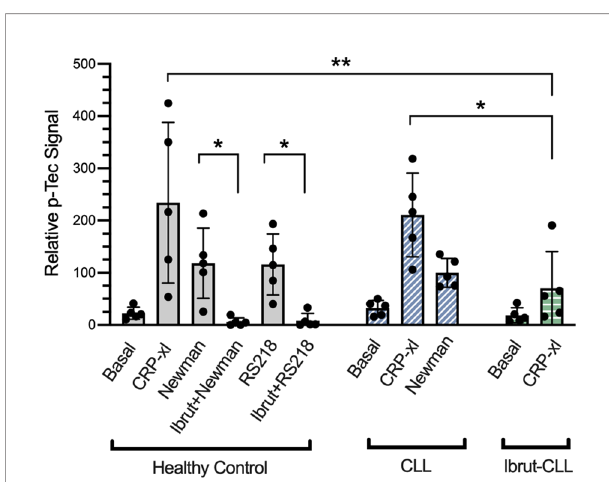
FIGURE 6 | Platelet responses to bacteria involve Tec kinase activation. Characterisation of platelet Tec phosphorylation in healthy controls (n=5), ibrutinib-untreated CLL (n=5) and ibrutinib-treated CLL (n=5) patients. Washed platelets from the three clinical groups were supplemented with fi brinogen and human IgG (commercially available IgGs pooled from healthy donors). Healthy control platelets were incubated in vitro with 5 m M ibrutinib, 15 m M acalabrutinib or vehicle for 5 minutes before adding agonists. Platelet samples were stimulated with either 3 m g/ml CRP-xl, S. aureus Newman or E. coli RS218. Relative phosphorylation of Tec was measured by a phospho- Tec ELISA. Data is shown as mean ± SD. Two-way ANOVA and Sidak ’ s multiple comparison test were used to compare CRP-xl responses across the three clinical groups. For the effect of ibrutinib on bacteria-induced phospho- Tec in healthy controls, one way ANOVA followed by Tukey ’ s multiple comparison correction was done. (*p ≤ 0.05, **p ≤